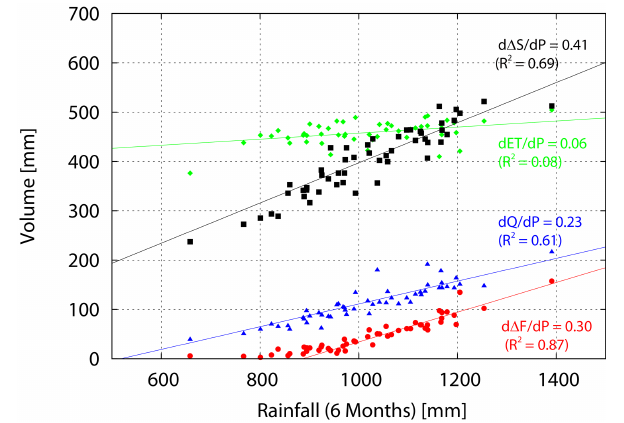
Figure 7. Relationship between cumulative rainfall ( P ) for 6 months and cumulative evapotranspiration (ET), cumulative runoff ( Q ), storage change ( (cid:49)S ) and inundation volume ( (cid:49)F ). Dots show the results from different years based on the 52-year simulation (without the dams).